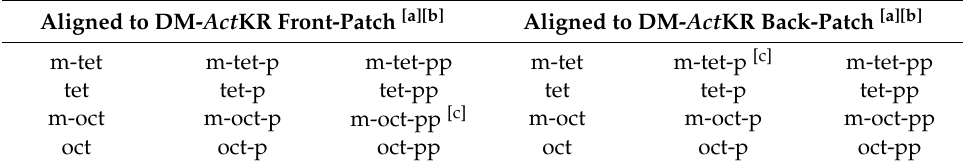
Table 1. Molecular dynamics (MD) simulation round 1, including 24 DM- Act KR-ligand